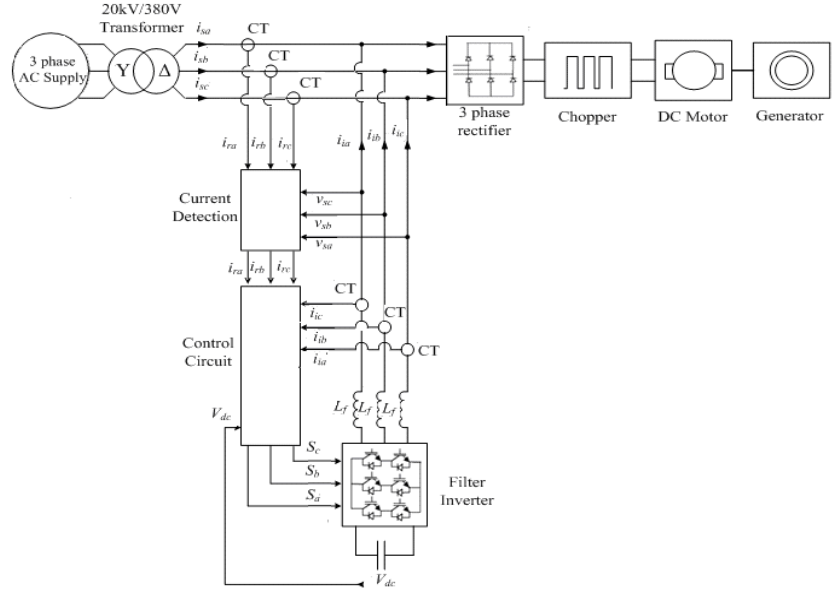
Figure 9. Test schema on stand with active filter of type shunt, with the recovery of braking energy.